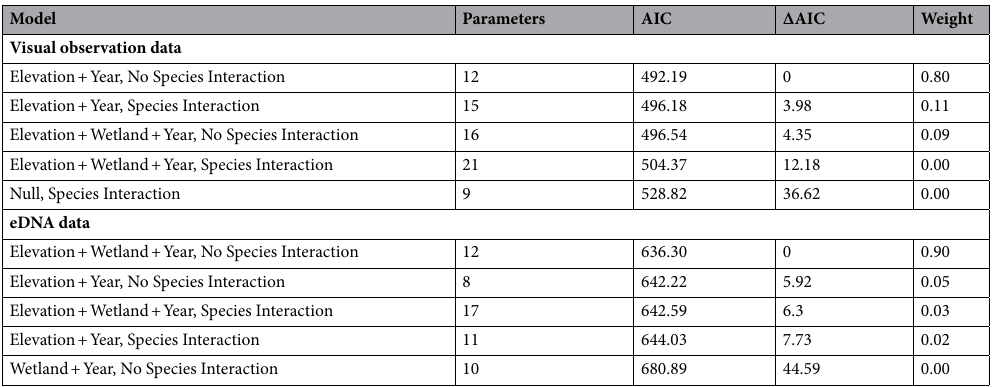
Table 3. Comparison of candidate models for the occupancy component of a multispecies occupancy model for the Hazara Torrent Frog ( Allopaa hazarensis ) and Murree Hills Frog ( Nanorana vicina ). Only the top five models for each data type are presented. AIC = Akaike Information Criterion, ΔAIC = the difference in AICc values between the given model and the model that is most likely to have generated the data (i.e., the one with the lowest AICc), and is a relative measure conditional on the candidate set of models.